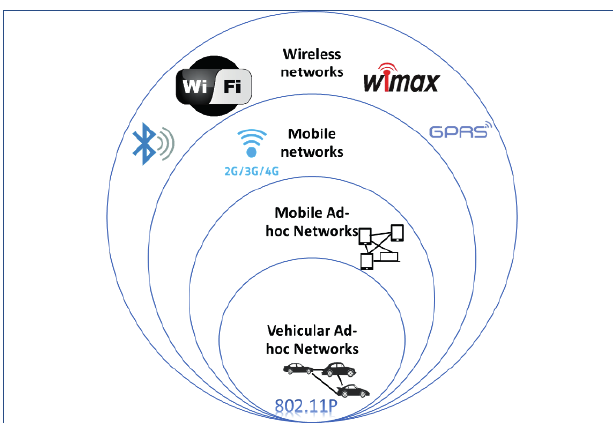
Fig. 1. VANET position in wireless networks.